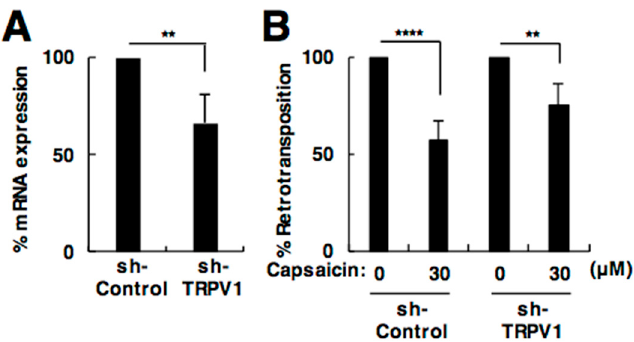
Figure 3. The effect of capsaicin on L1 is independent of TRPV1. ( A ) Expression of TRPV1 by transfection of plasmids expressing sh-TRPV1. ( B ) Effect of capsaicin on L1 retrotransposition in TRPV1 knockdown cells. 293T cells were transfected with the L1 retrotransposition reporter construct, together with a plasmid expressing sh-TRPV1. After 24 h, 30 µM capsaicin was added. Luciferase activity in the cells was evaluated at 4 days post-transfection. Values are expressed as the means + S.E. of at least four independent experiments. ** p < 0.01; **** p < 0.001.